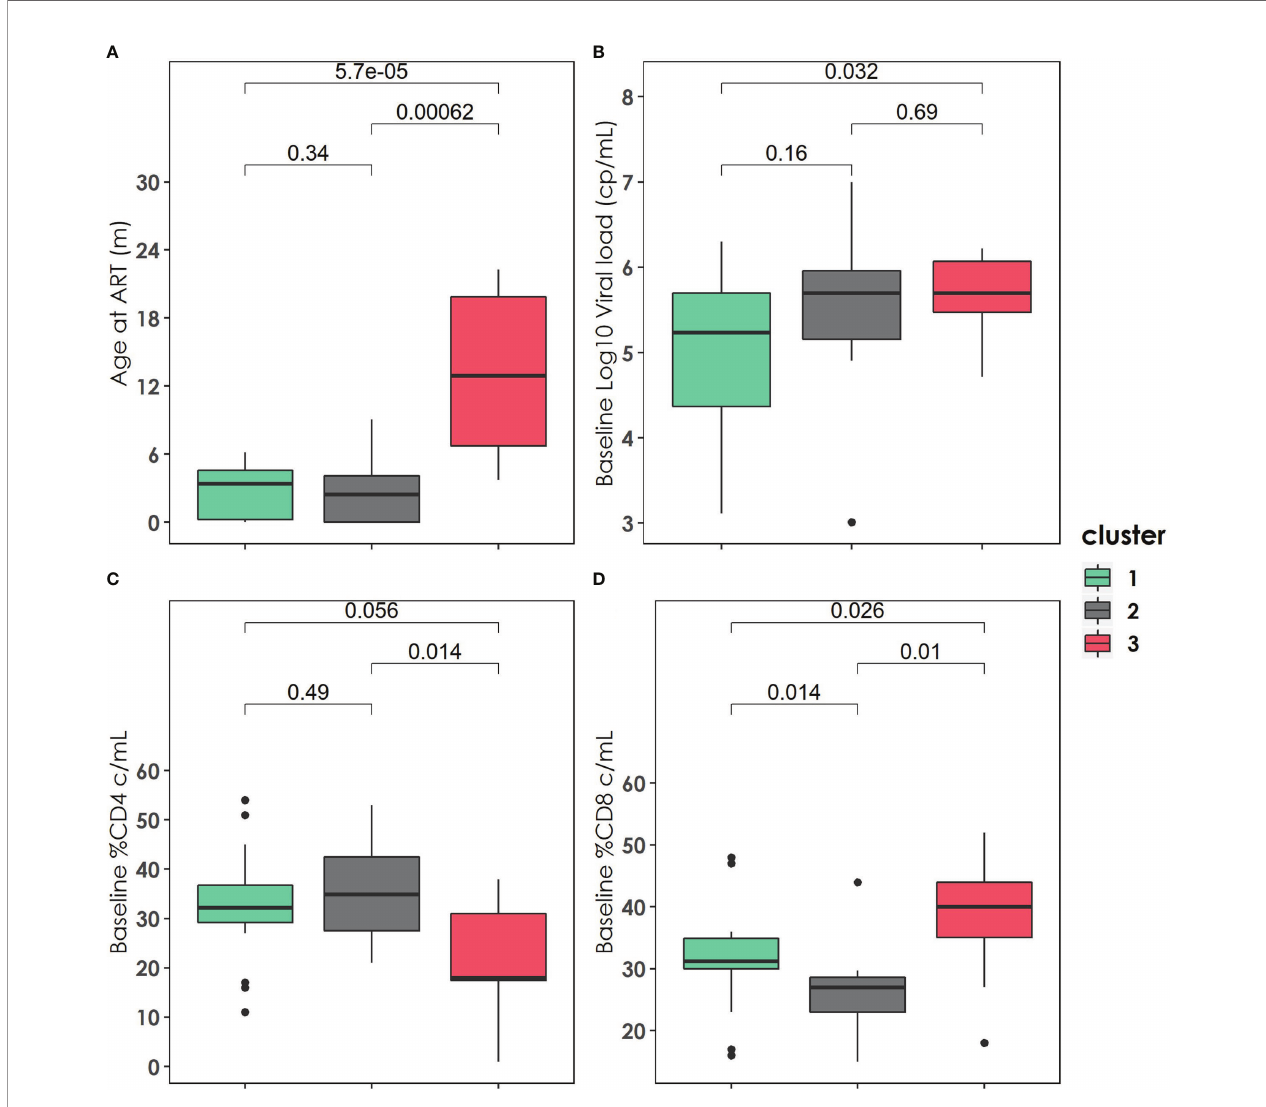
FIGURE 2 | Baseline clinical, immunological, and virological characteristics of the three clusters described. (A) Age at antiretroviral treatment distribution among the three clusters. (B) Baseline Log10 Viral load (copies/mL) distribution among the three clusters. (C) Baseline % CD4 (cell/mL) distribution among the three clusters. (D) Baseline %CD8 (cell/mL) distribution among the three clusters. P-values were calculated using U-Mann Whitney Test and Kruskal-Wallis test when